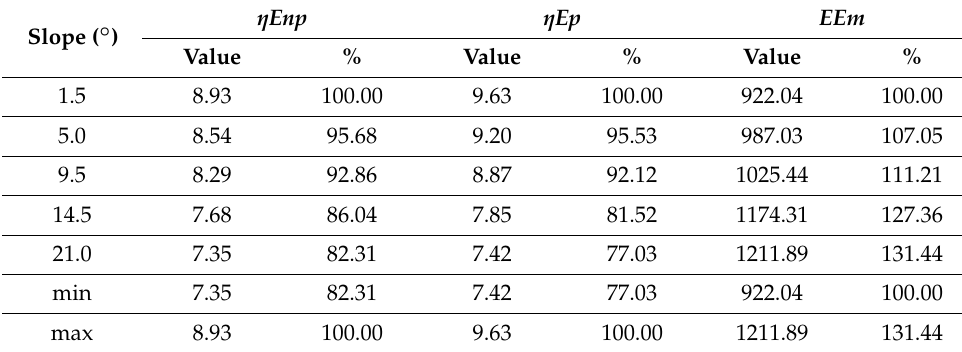
Table A11. Average emissions and efficiency of crops according to the slope.